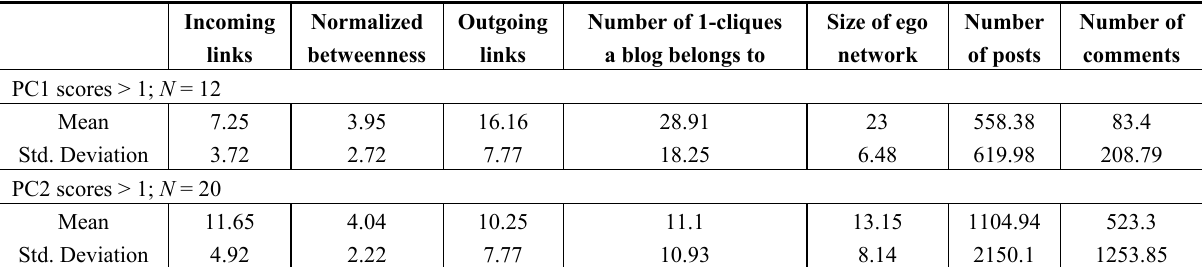
Table 5. Descriptive statistics of the social network and activity indexes for best performing blogs according to PC1 and PC2.